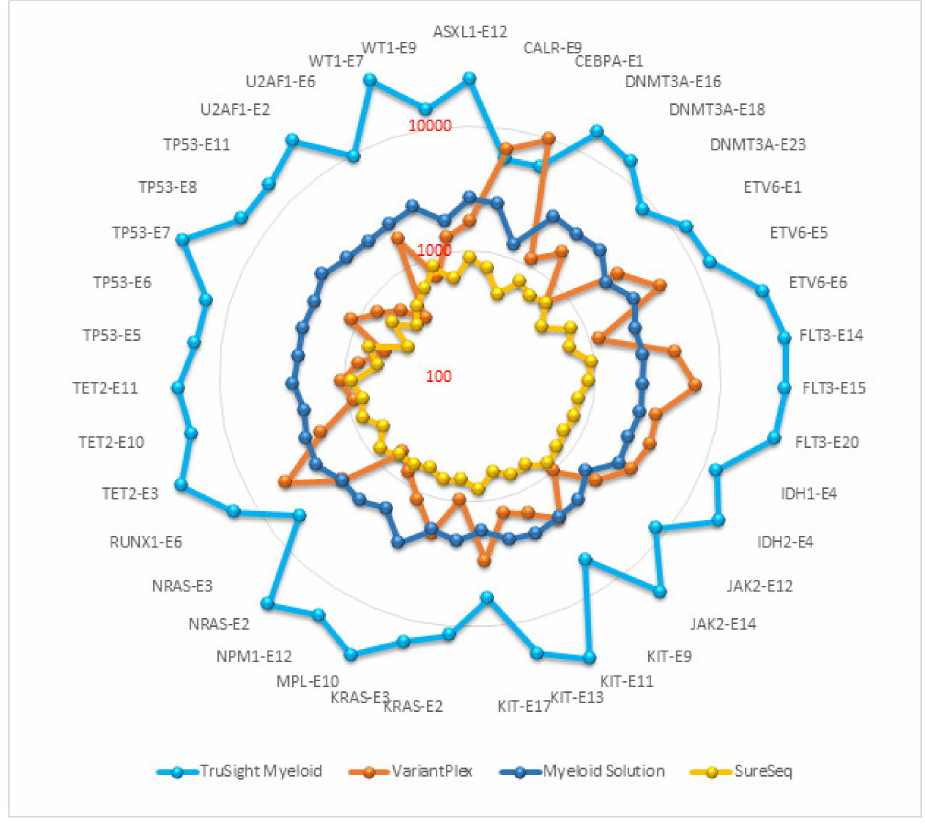
Figure 1. Average coverage of core myeloid